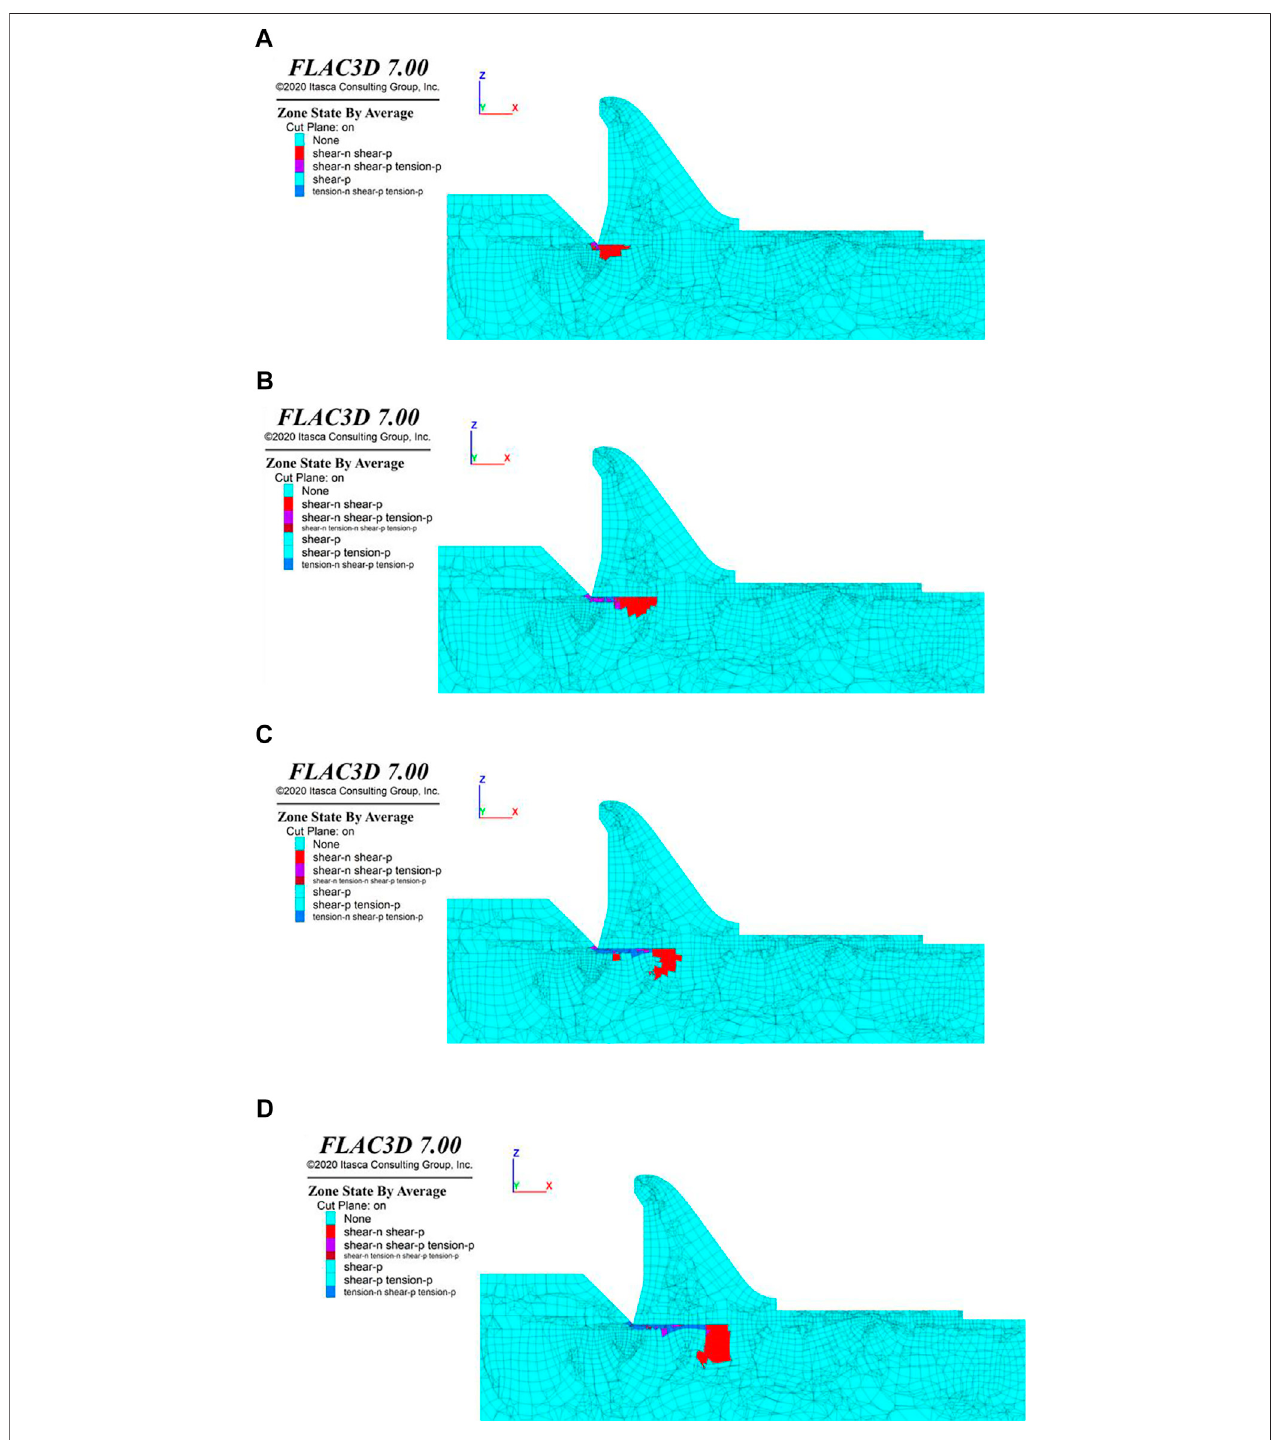
FIGURE9 | Plastic zones in the pro fi le cutting through thecenter ofdam section 6 under the conditions of (A) overload coef fi cient 2.0, (B) overload coef fi cient 3.0, (C) overload coef fi cient 4.0, and (D) overload coef fi cient 5.0.